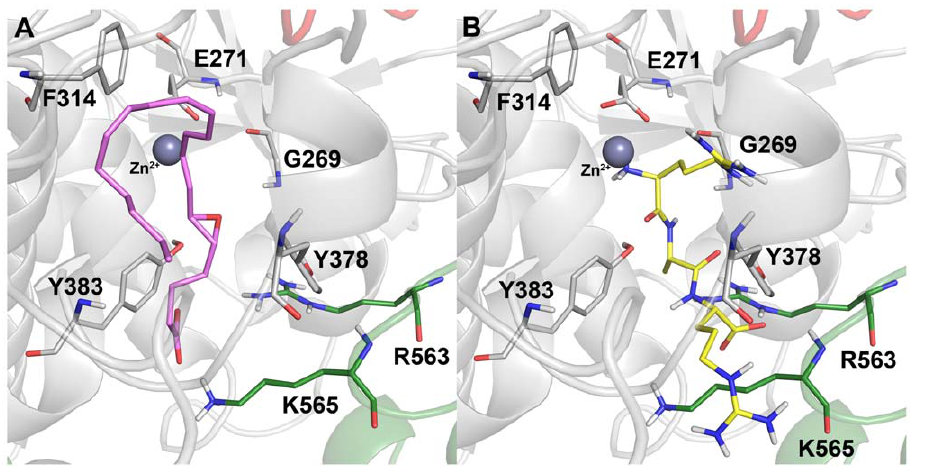
Figure 3. The initial binding poses. (A) LTA4 and (B) RAR selected from the molecular docking studies to be subjected to MD simulations. doi:10.1371/journal.pone.0041063.g003 whereas E271Q and K565A systems have shown similar average distance value of 0.69 nm and 0.63 nm, respectively. During the end of the simulations, this distance in E271Q and K565A systems has reduced close to the distance of WT but R563A has maintained higher distance until the end (Figure 5A). In terms